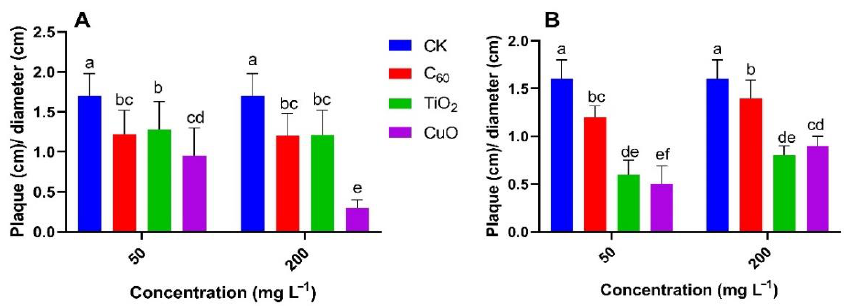
Figure 3. Effect of nanomaterial treatment on the mean ratio of plaque depth (cm) to plaque diameter (cm) for two sweet potato cultivars: ( A ) Y25 and ( B ) J26. Different small letters represent significant difference according to Duncan’s multiple range test ( p < 0.05. n = 3). Figure 4. Representative scanning electron microscopic (SEM) images of the cross sections of inoculated sweet potato ( A ) representing Y25 cultivar and ( B ) representing J26 cultivar of sweet potato at different concentrations of NMs.